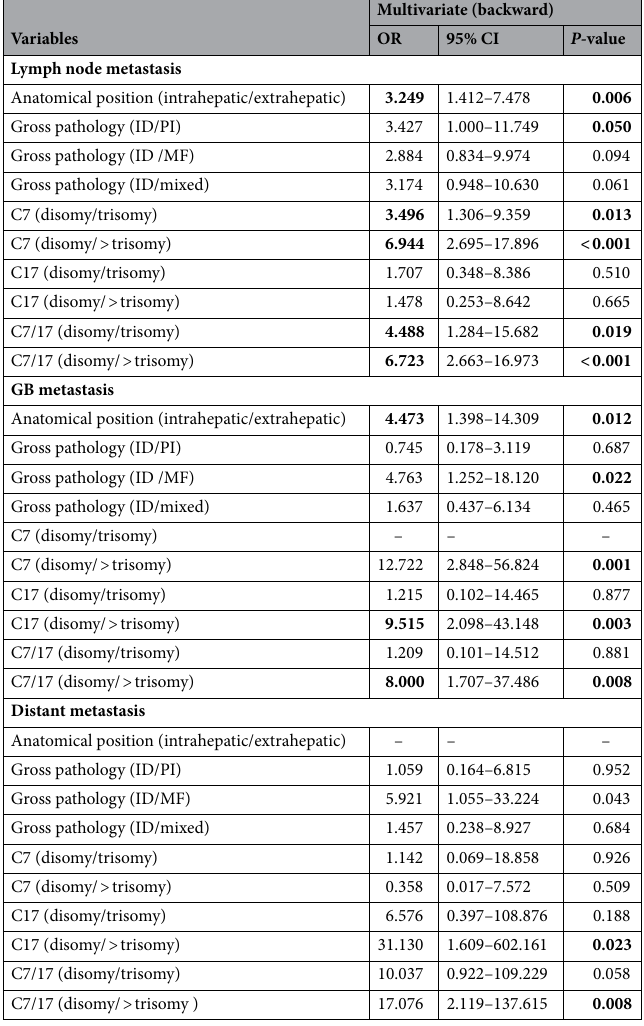
Table 4. Multivariate analysis of the factors related to